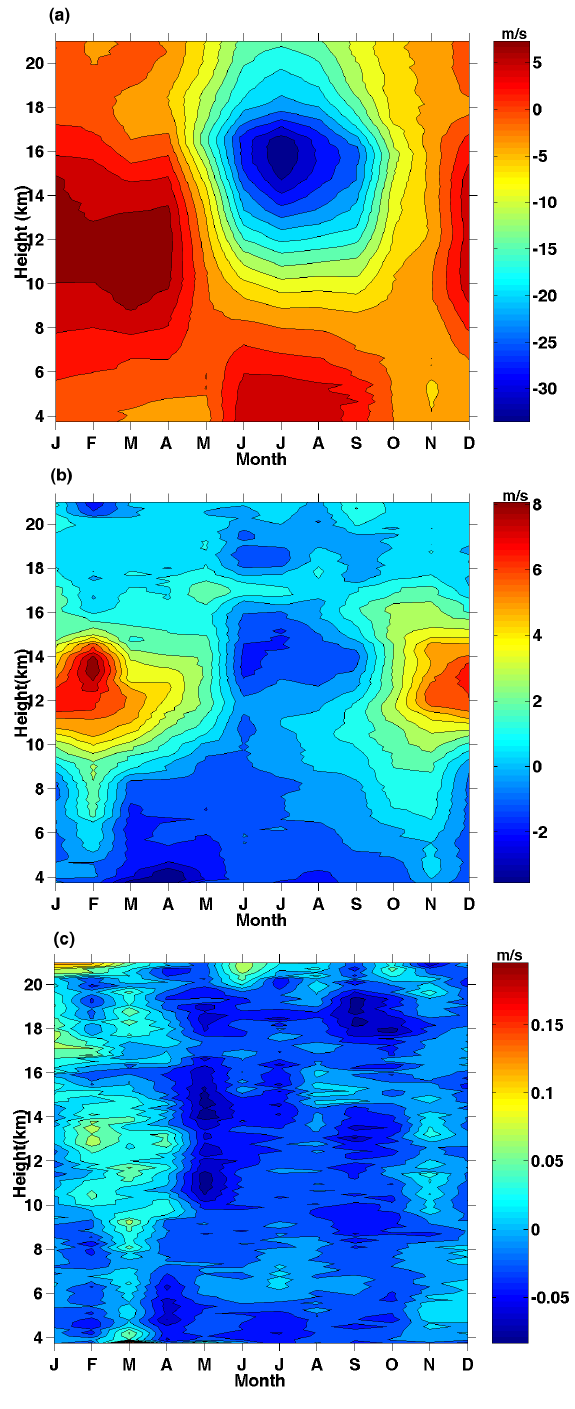
Fig. 2. Ten-year climatology of (a) Zonal, (b) Meridional and (c) vertical winds over